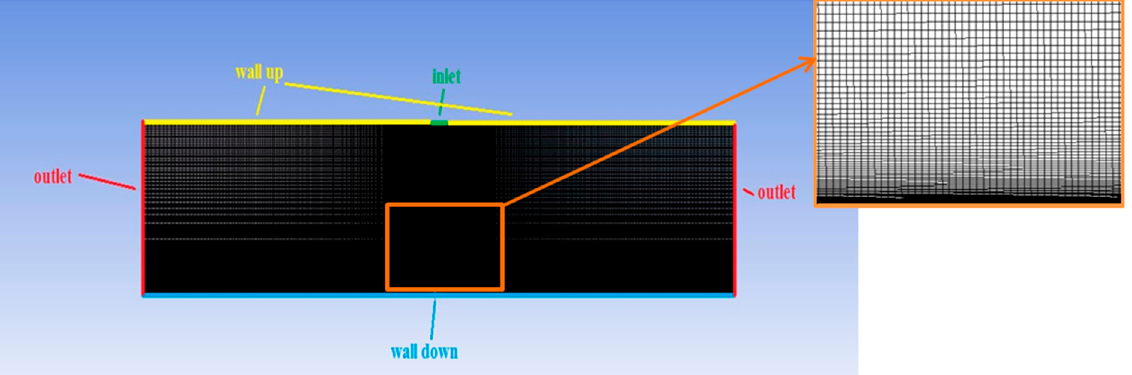
Figure 5. Computational grid of a single slot configuration.